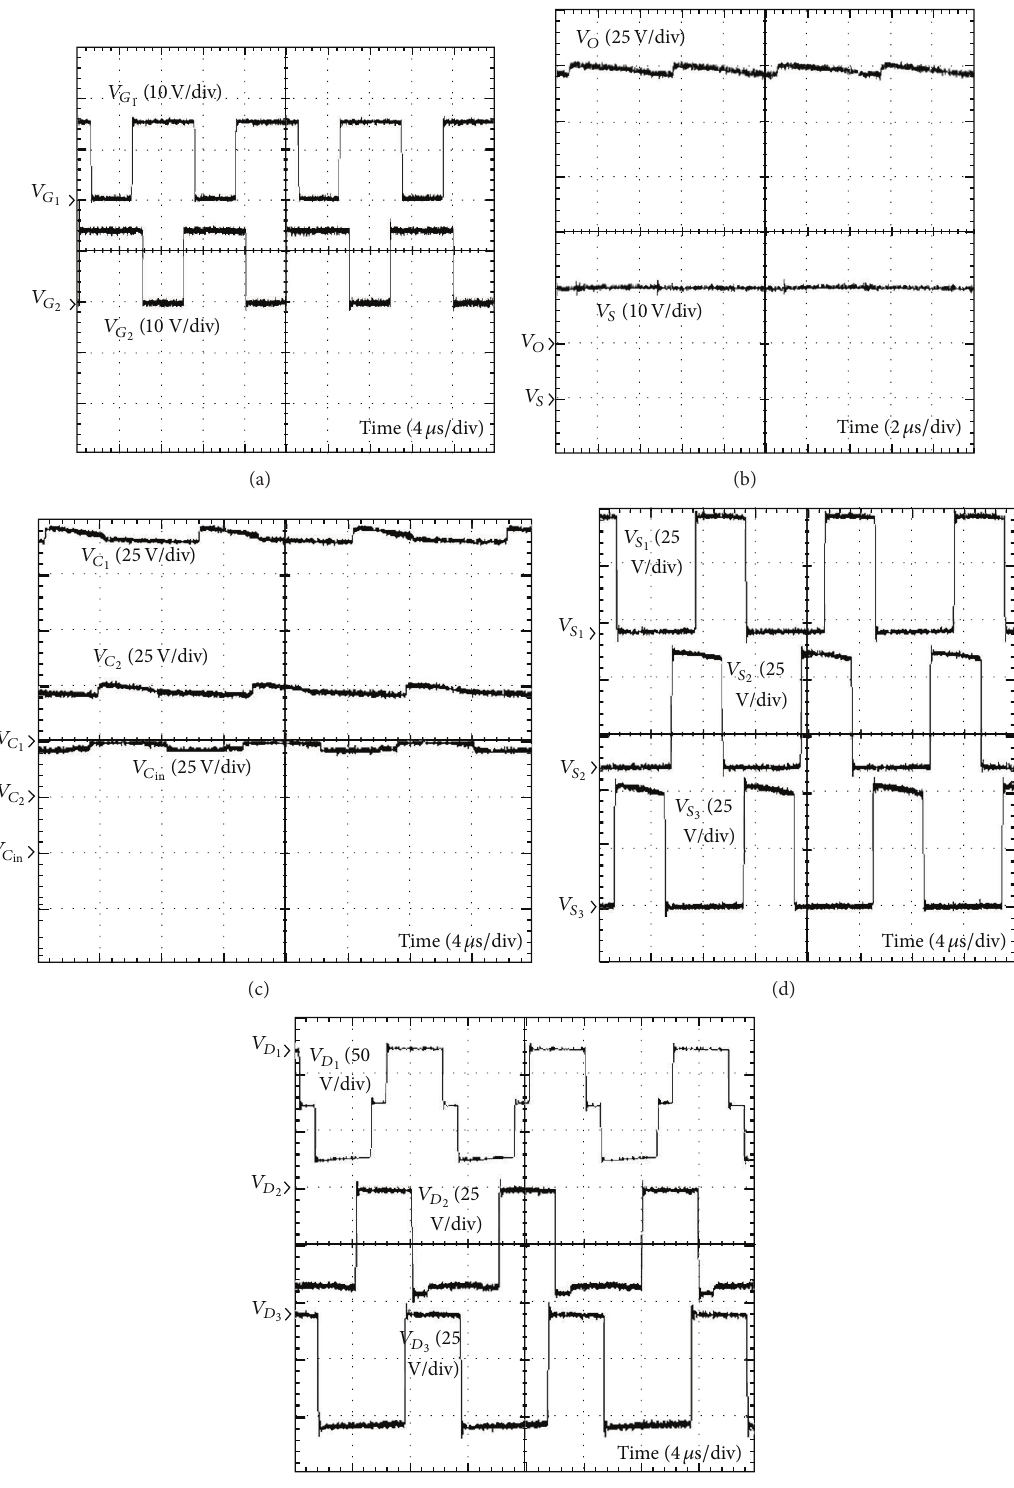
Figure6:Experimentalwaveformsoftheproposedconverter.(a)WaveformsofPWMsignals 𝑉 𝐺 ofsupplyvoltage 𝑉 𝑆 andoutputvoltage 𝑉 𝑂 .(c)Waveformsofvoltages 𝑉 𝐶 , 𝑉 𝑆 and 𝑉 𝑆 of MOSFETs 𝑆 1 , 𝑆 2 , and 𝑆 3 . (e) Waveforms of voltage stresses 𝑉 𝐷 stresses 𝑉 𝑆 1 2 3